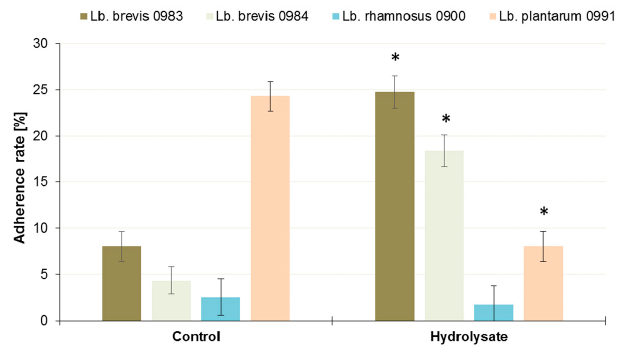
Figure 5. Adherence of Lactobacillus sp. strains to Caco-2 cell monolayers in the presence of SBP hydrolysate relative to the control samples. The data represent means from three replicates in one experiment. Error bars denote SD. * Results significantly differ from the relevant control, ANOVA ( p < 0.05). Table 2. Stimulation/inhibition of adherence to Caco-2 cell monolayers for tested microbial strains in the presence of SBP hydrolysate.